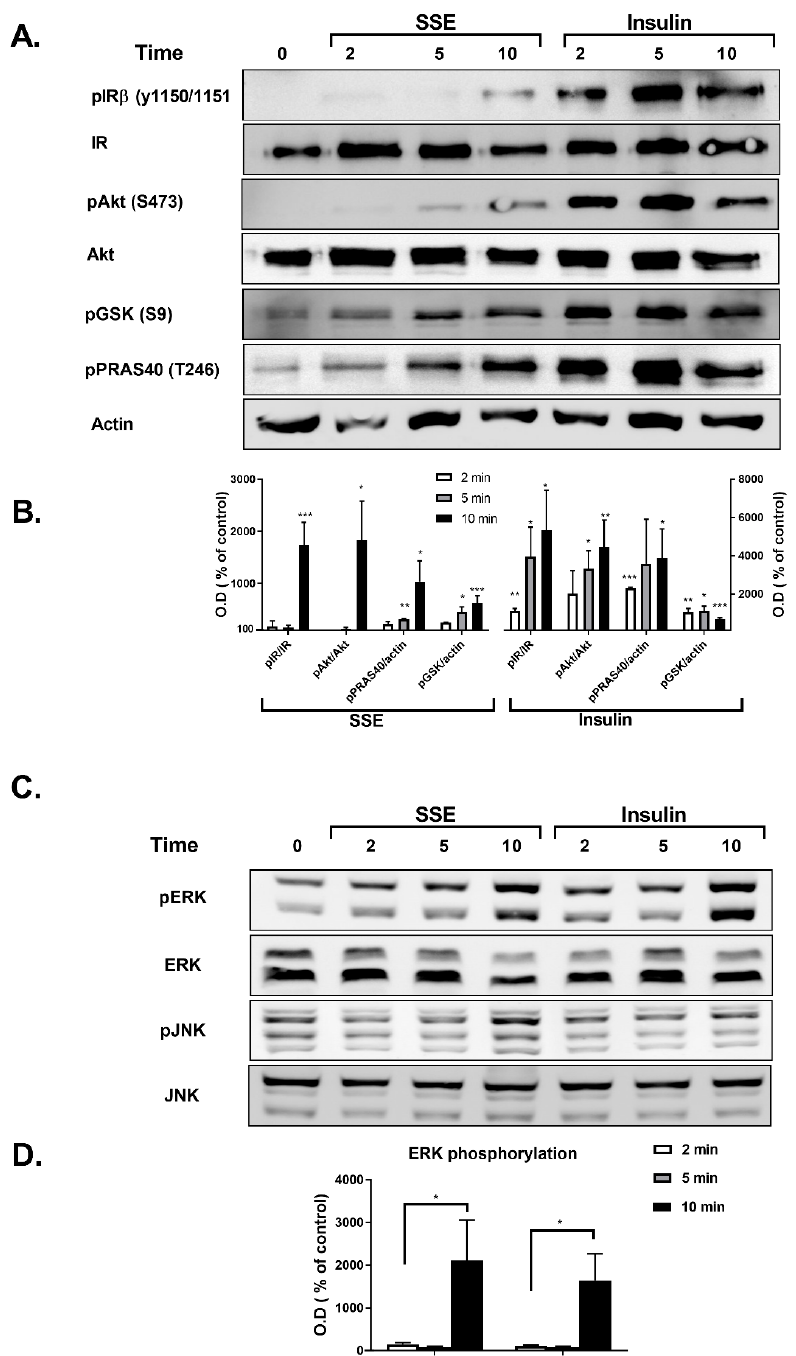
Figure 3. SSE phosphorylates components of the PI3K-Akt and MAPK pathway in L6 myotubes. L6 myotubes were treated with insulin or SSE for the indicated time. ( A , B ). Western blot analysis of proteins involved in PI3K-Akt pathway and a graph of optical densitometry (OD) measurements. ( C ) and ( D ). Western blot analysis of proteins involved in MAPK pathway and a graph of OD measurements. These are representative results of 3 independent experiments. Phosphorylation level was normalized to the expression of the proteins. Results are presented as % of control. Each bar represents the mean ± SE of data obtained in three separate experiments. * p < 0.05, ** p < 0.005, and *** p < 0.0005 vs. control, analyzed by Student’s t